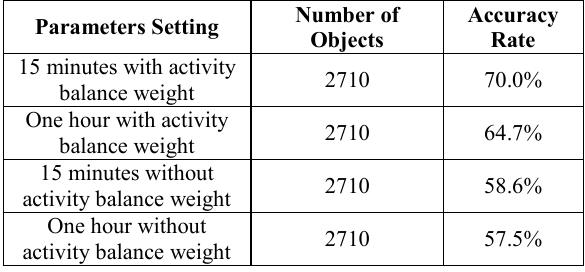
Table 2. The result of Experiment